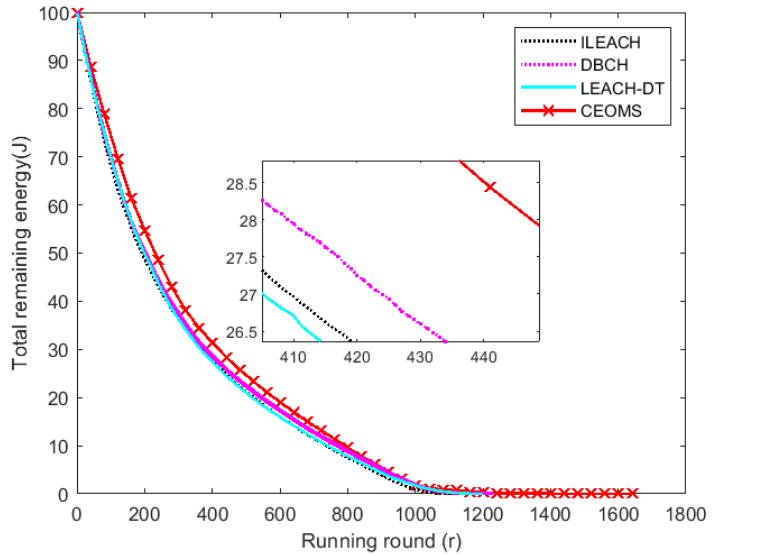
Figure 13. Change trend of total residual